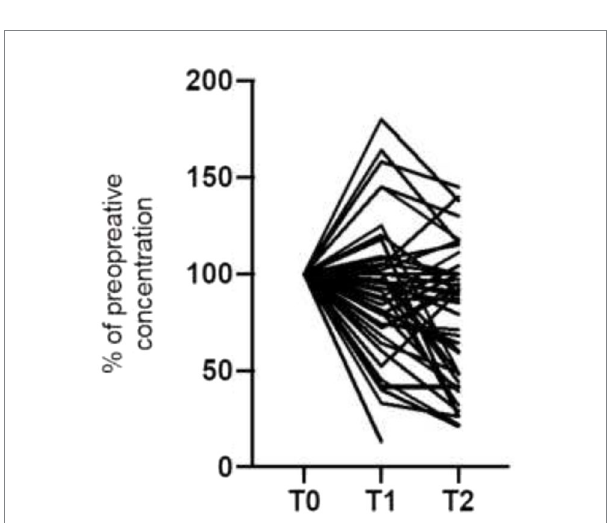
FIGURE 3 Individual course of the plasma concentration of antidepressants SSRI/SNRI in patients undergoing bariatric surgery ( n = 46): before (T0), 1 month (T1), and 6 months (T2) after bariatric